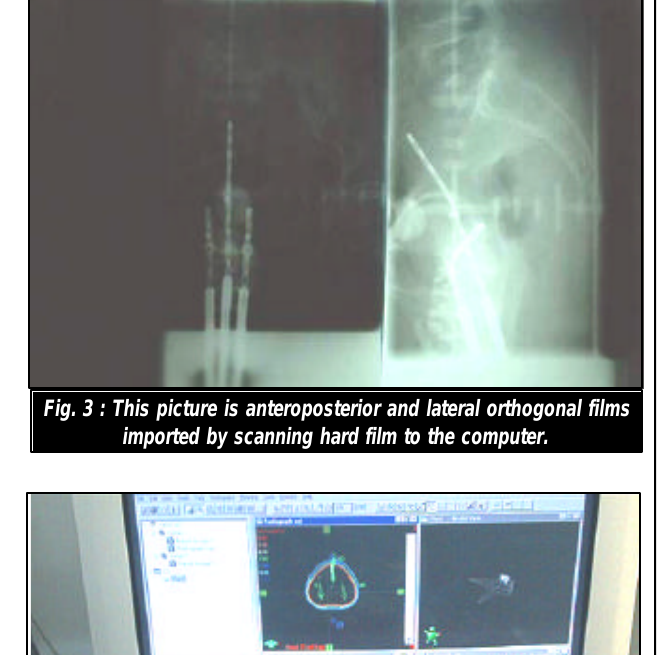
Fig. 4 : This is picture of the computer planning where here dimensional isodose distribution is visualised.